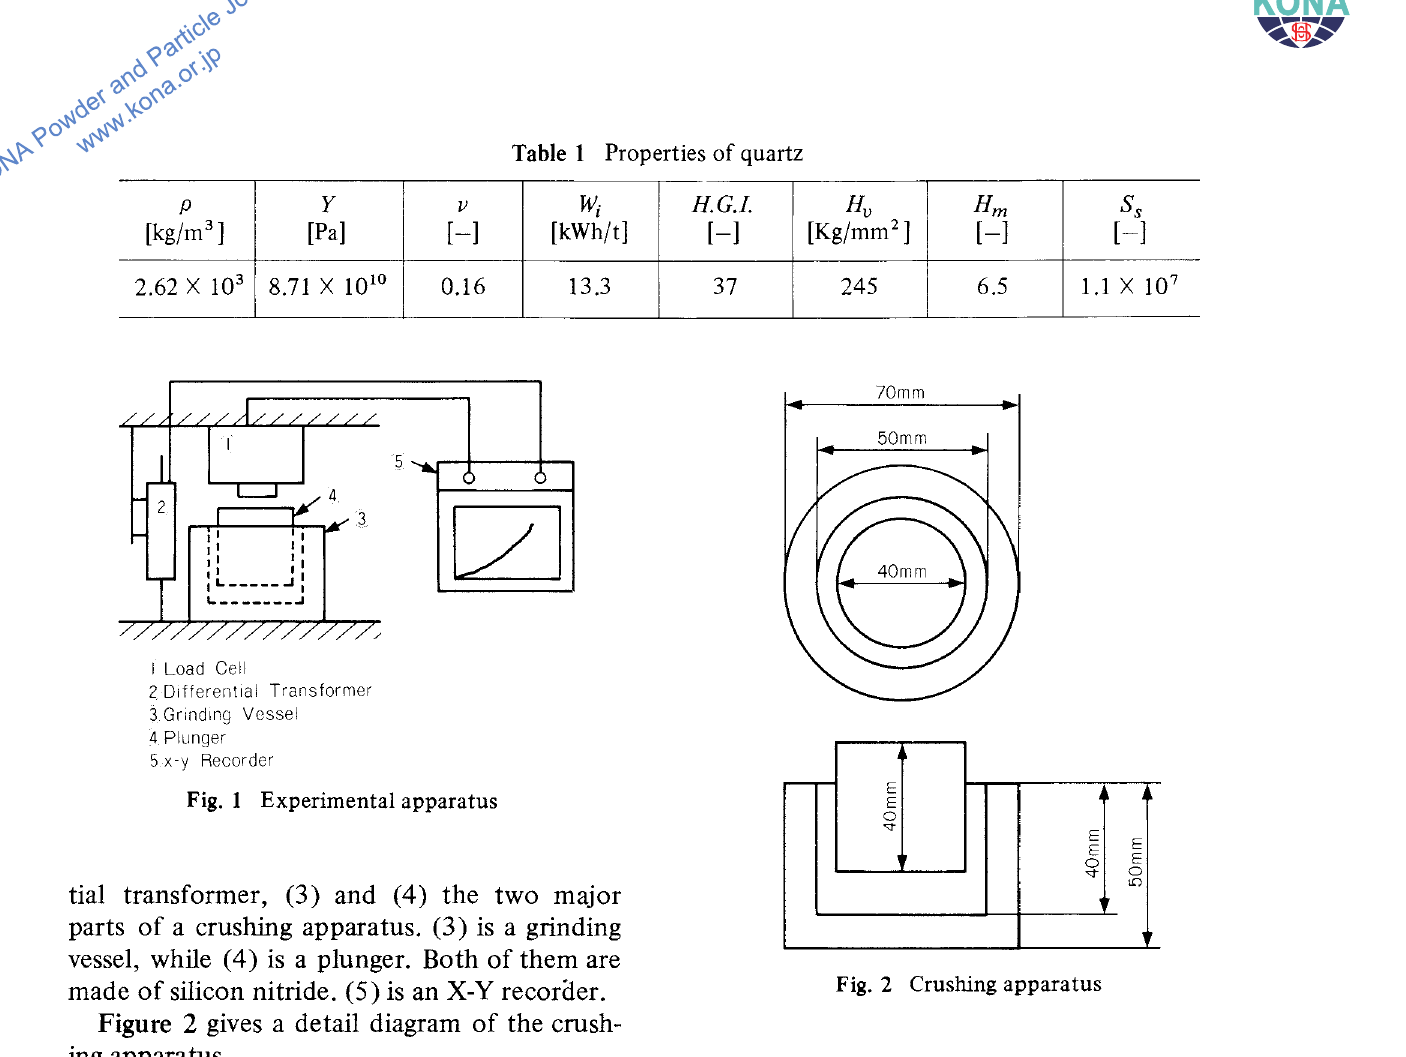
using Showa Sokki's pellet tester. In the